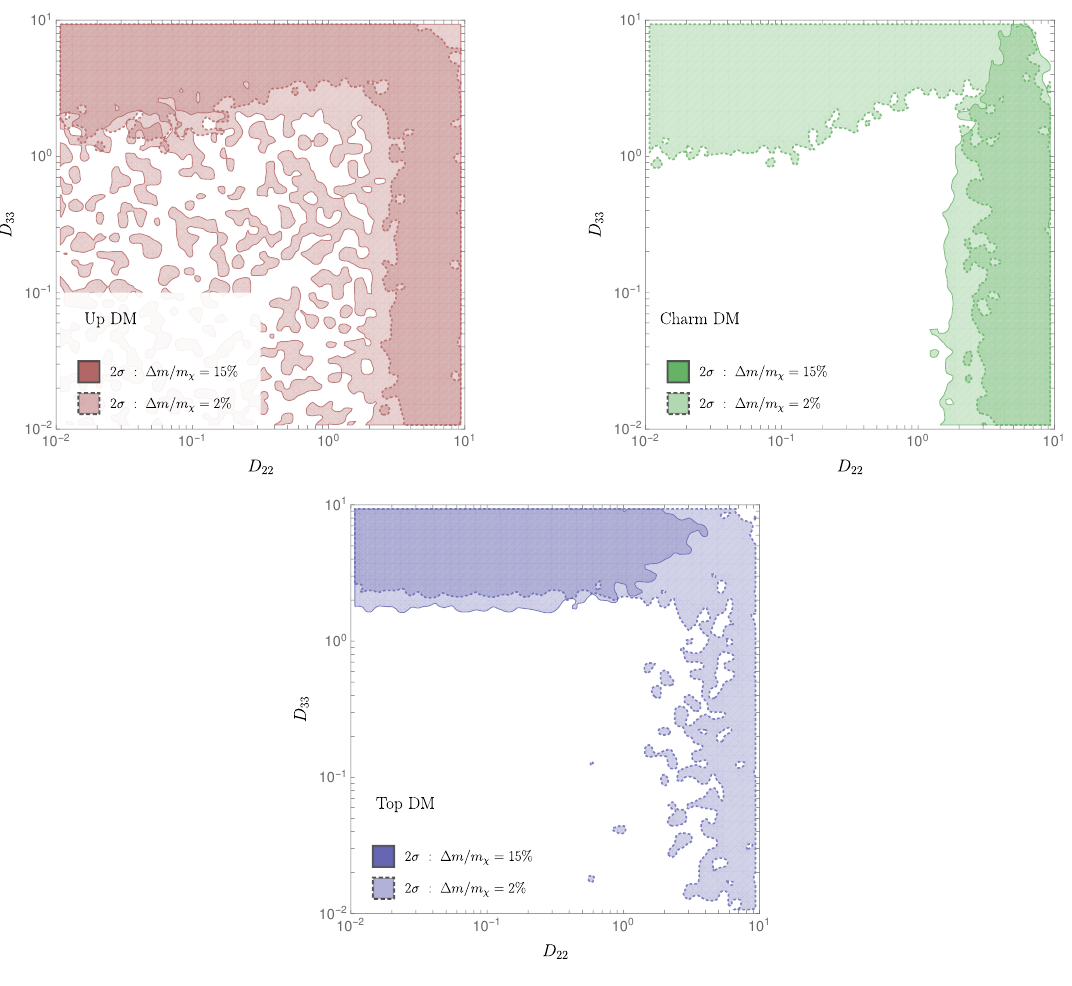
Figure 16 . As for (cid:12)gure 14 but for the D